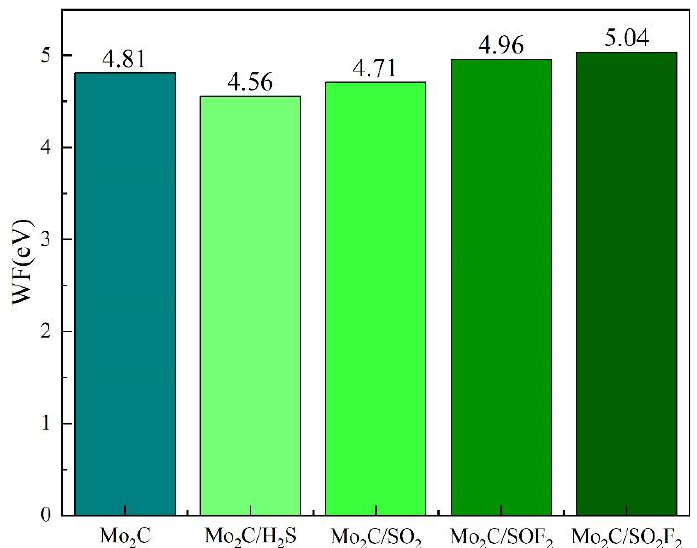
Figure 6. WF of adsorption systems.